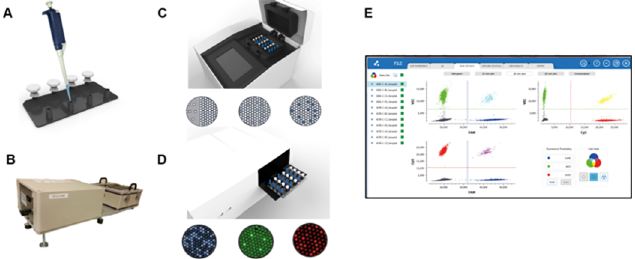
Fig 1. The Naica System for Crystal Digital PCR. The system comprises SapphireChips v1 (A.), in which the sample is partitionedas droplet crystals using the Stilla loadingdevice (B), the Naica Geode (C), which will perform thermal cycling, the Naica Prism3 (D), which enablesthe fluorescent readout of the droplet crystals in three detectionchannels (Blue, Green and Red), and finally, the Crystal Miner analysissoftware (E) for data extraction and concentration calculations from images acquiredwith the